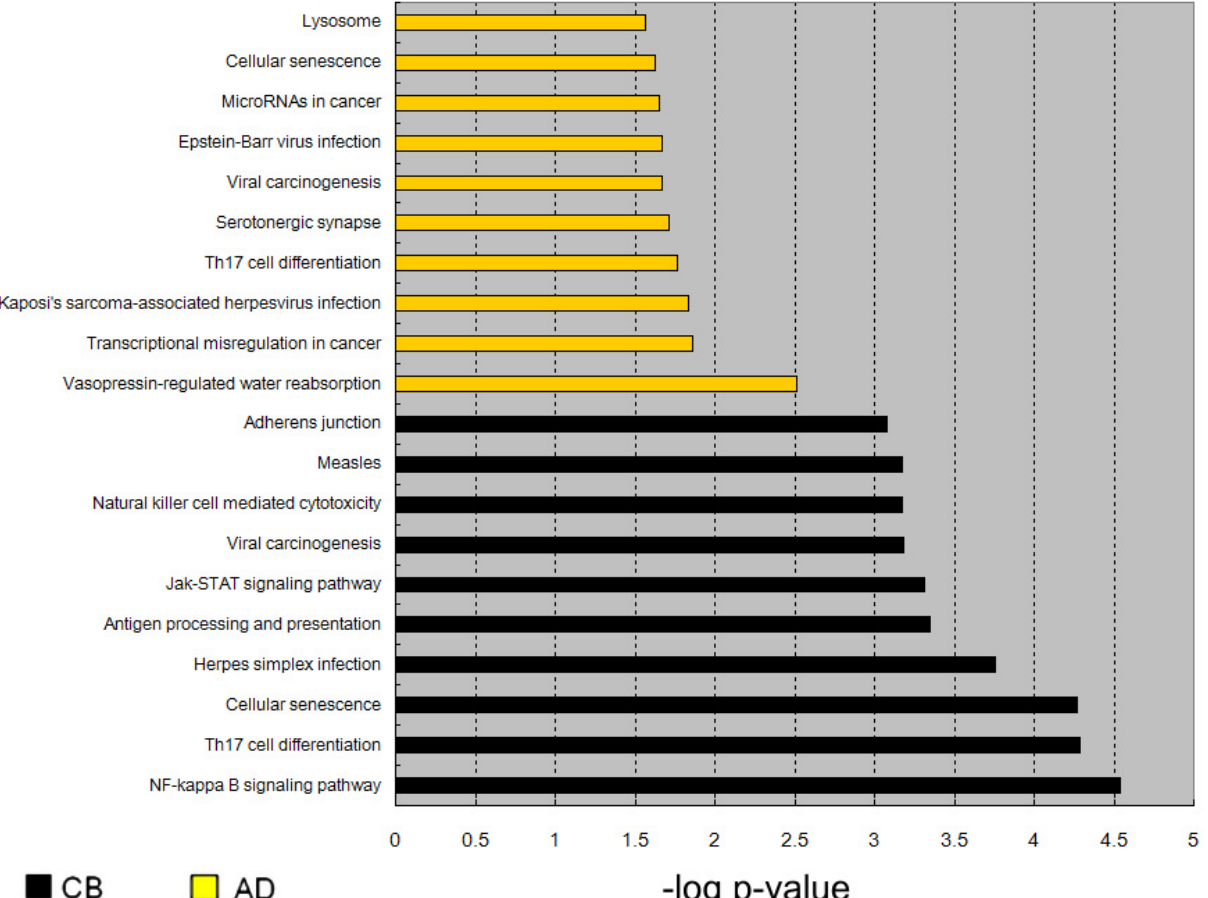
Figure 5. Comparisons of enriched pathways between cord blood (CB) and adult blood (AD). We identified significantly hypomethylated CpG dinucleotides (CT vs. CC, comparing the factor L -arginine treatment) and identified activated genes of cord blood and adult blood samples, followed by pathway analysis. We then compared the top-10 most significant pathways identified in either CB or AD samples.